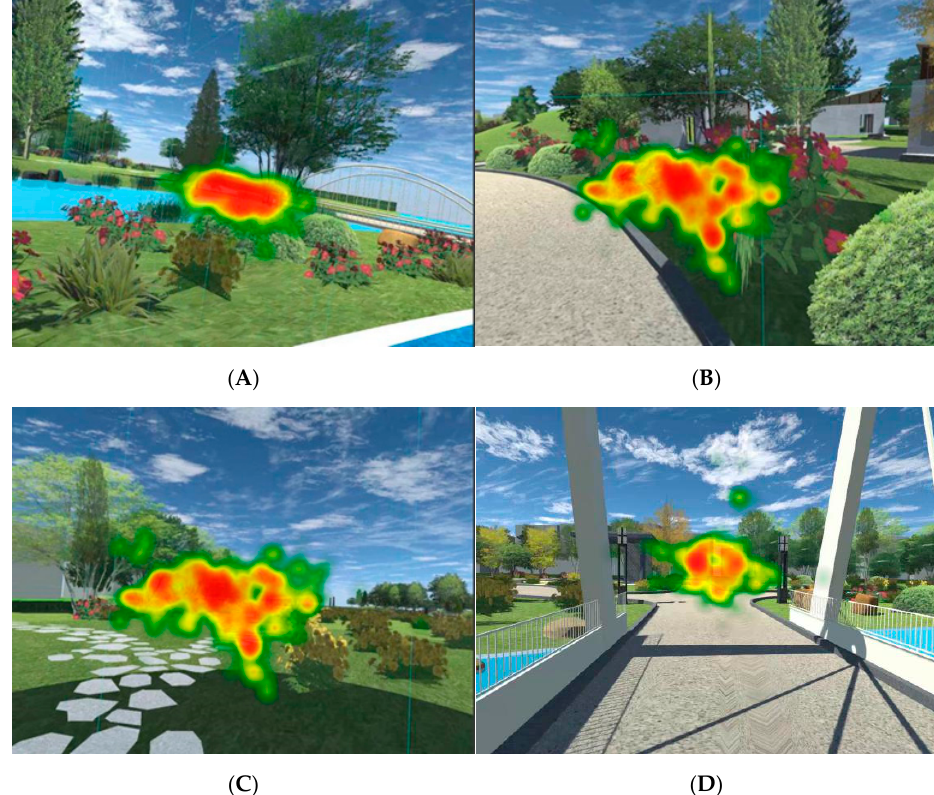
Figure 7. Heat map of eye movement and fixation changes in the region of interest. Source: ErgoLAB platform export. ( A ) Vegetation landscape interest area and heat map; ( B ) flower landscape heat map; ( C ) heat map of interest area of road landscape; ( D ) heat map of architectural landscape interest